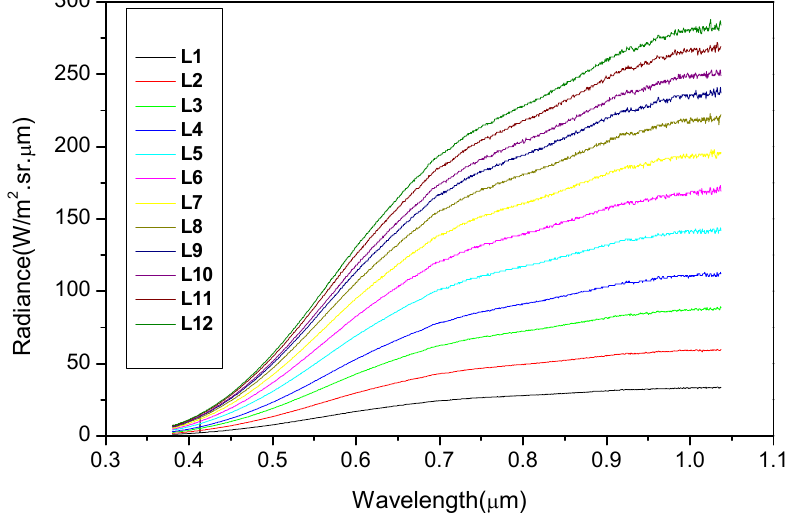
) for each illumination level λ